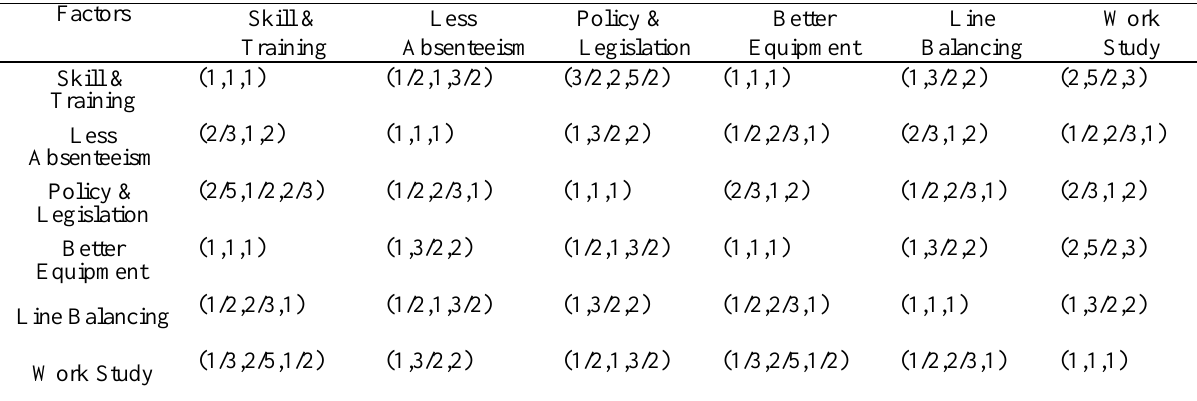
Table 1. Data for FAHP